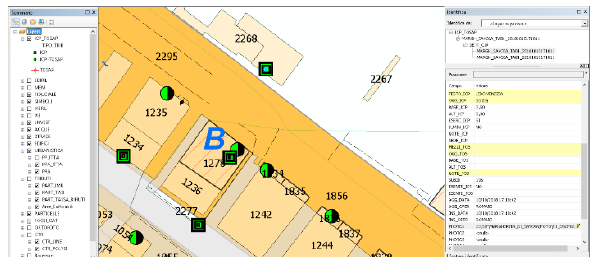
Figure 8. Manual survey performed by user based on cadastral platform